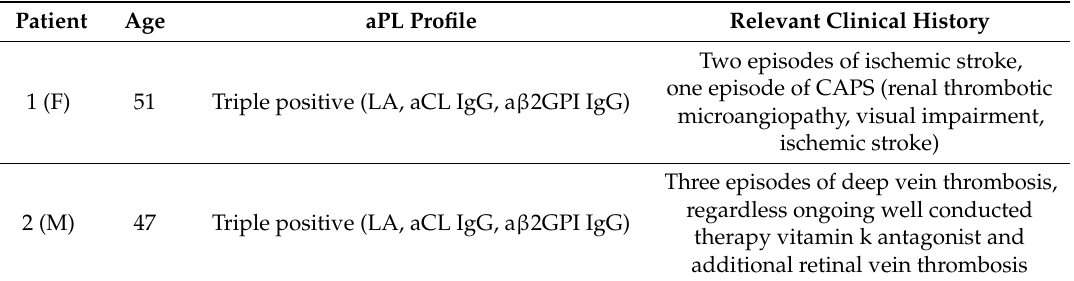
Table 2. Main clinical and laboratory characteristics of the patients included in the